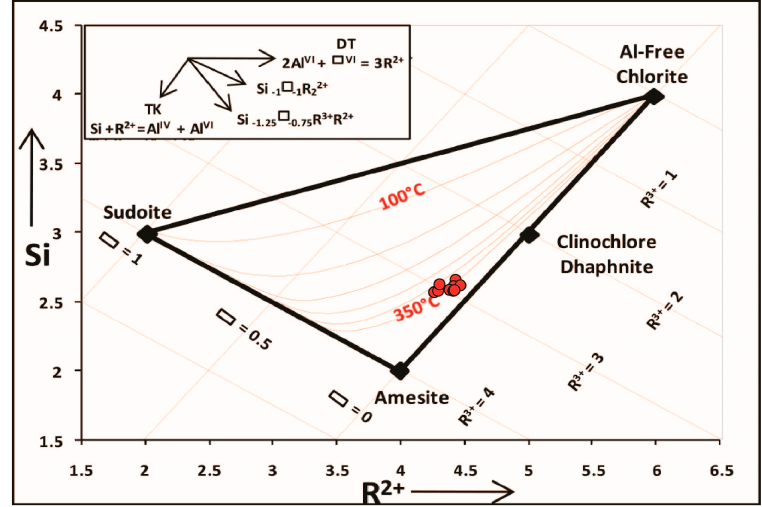
Figure 4. Chemical composition of chlorites from the Larderello geothermal field [52] plotted in the T-R 2+ –Si diagram of Bourdelle and Cathelineau [77].